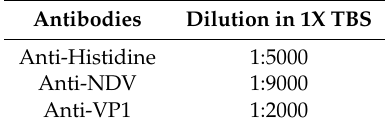
Table 1. Dilution of antibodies in 1X